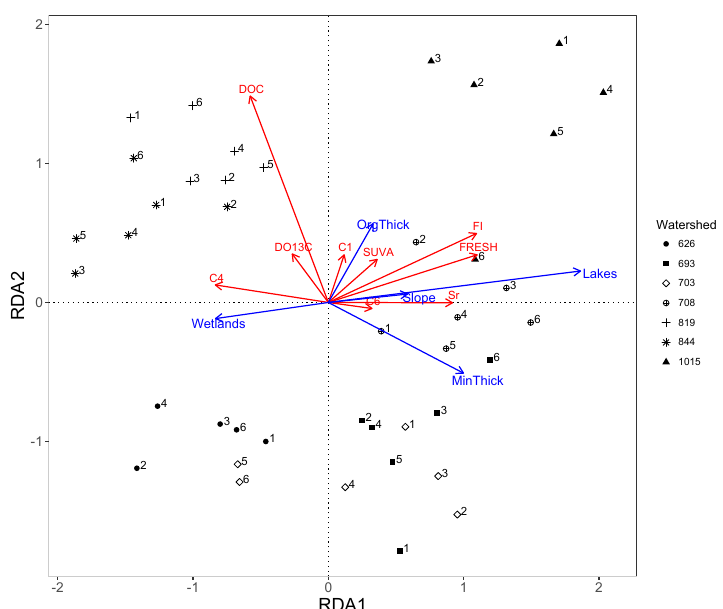
Figure 7. Results from the partial redundancy analysis (RDA; type 2 scaling) of DOC concentration and DOM composition versus watershed characteristics. Angles between vectors represent correlation; i.e., smaller angles indicate higher correlation. Symbols represent different watersheds, and numbers on symbols represent the sample month in 2016: 1 – January; 2 – February; 3 – March; 4 – early April; 5 – late April; and 6 –